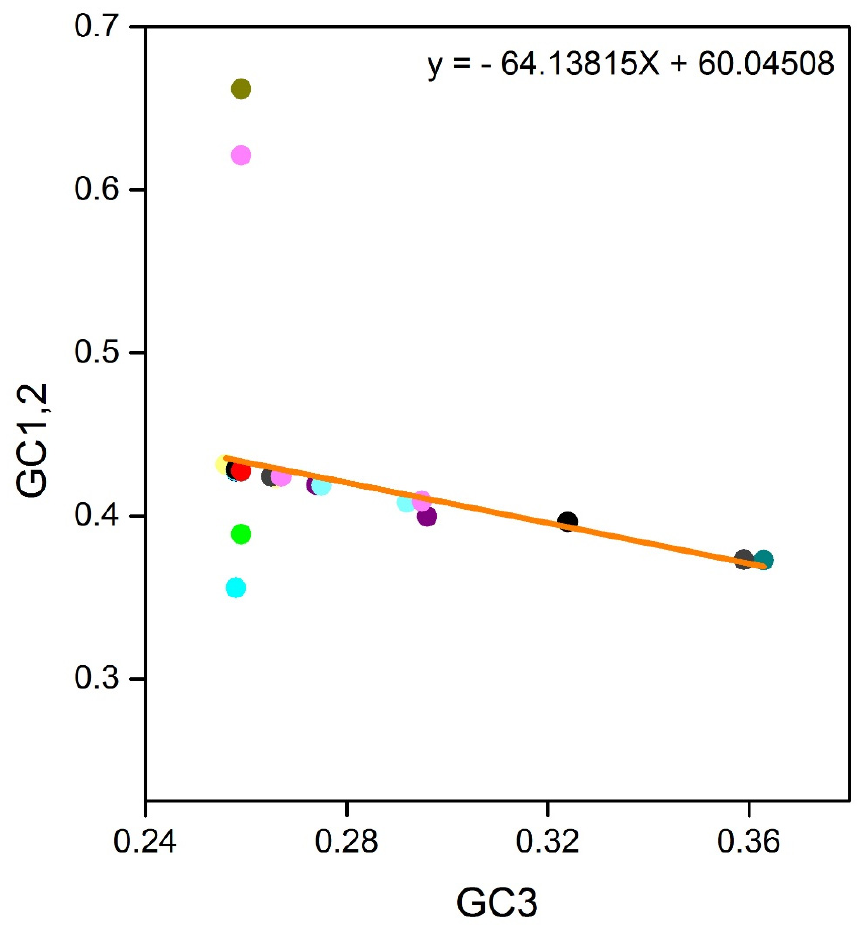
Figure 4. Neutrality plot analysis (GC12 vs. GC3) plots of 60 SARS-CoV-2 isolates are represented in different color schemes. GC12 stands for the average value of G.C. contents at the first and second positions of the codons (GC1 and GC2), while GC3 refers to the G.C. contents at the third codon position.